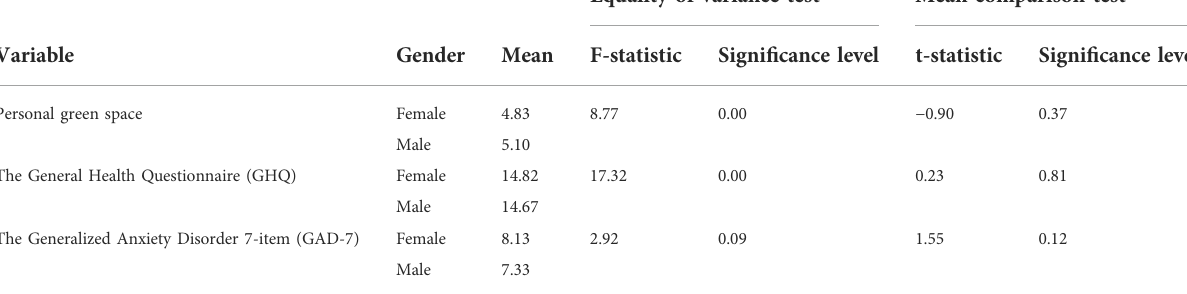
TABLE 7 t -test at the gender level.